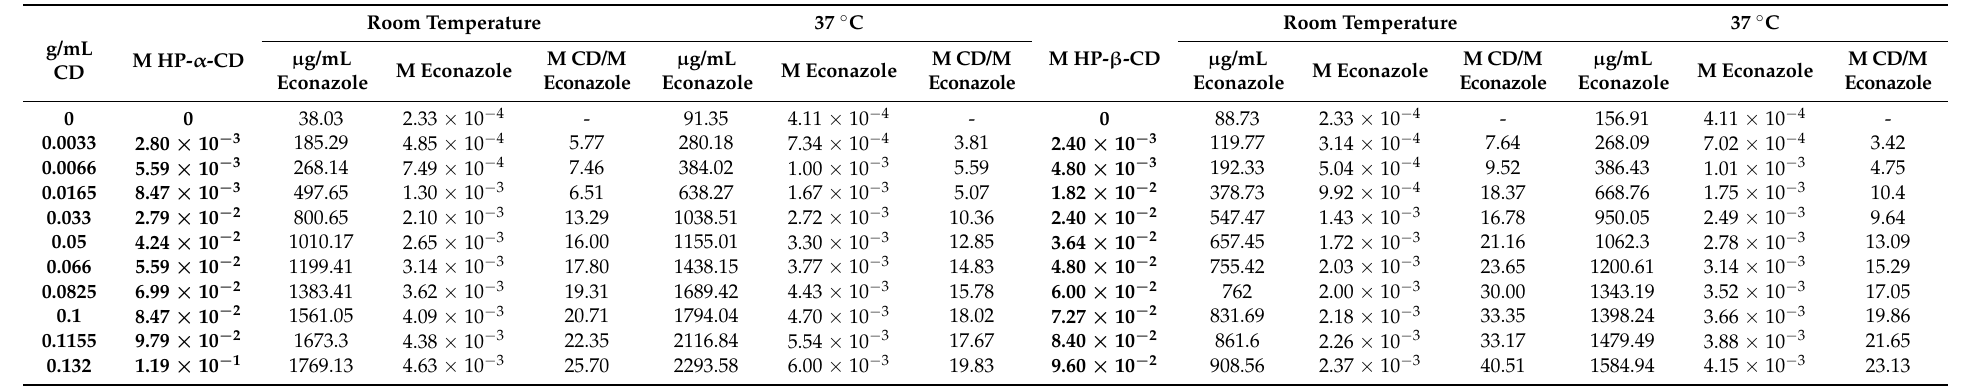
Table 1. Solubility of econazole with increasing amounts of HP- α -CD or HP- β -CD in PBS at room temperature and 37 ◦ C, and molar ratios of cyclodextrin–econazole in saturated PBS solution. MW HP- α -CD = 1180, HP- β -CD = 1375, econazole nitrate = 381.683 (to convert g/mL to M, multiply concentration by 10 3